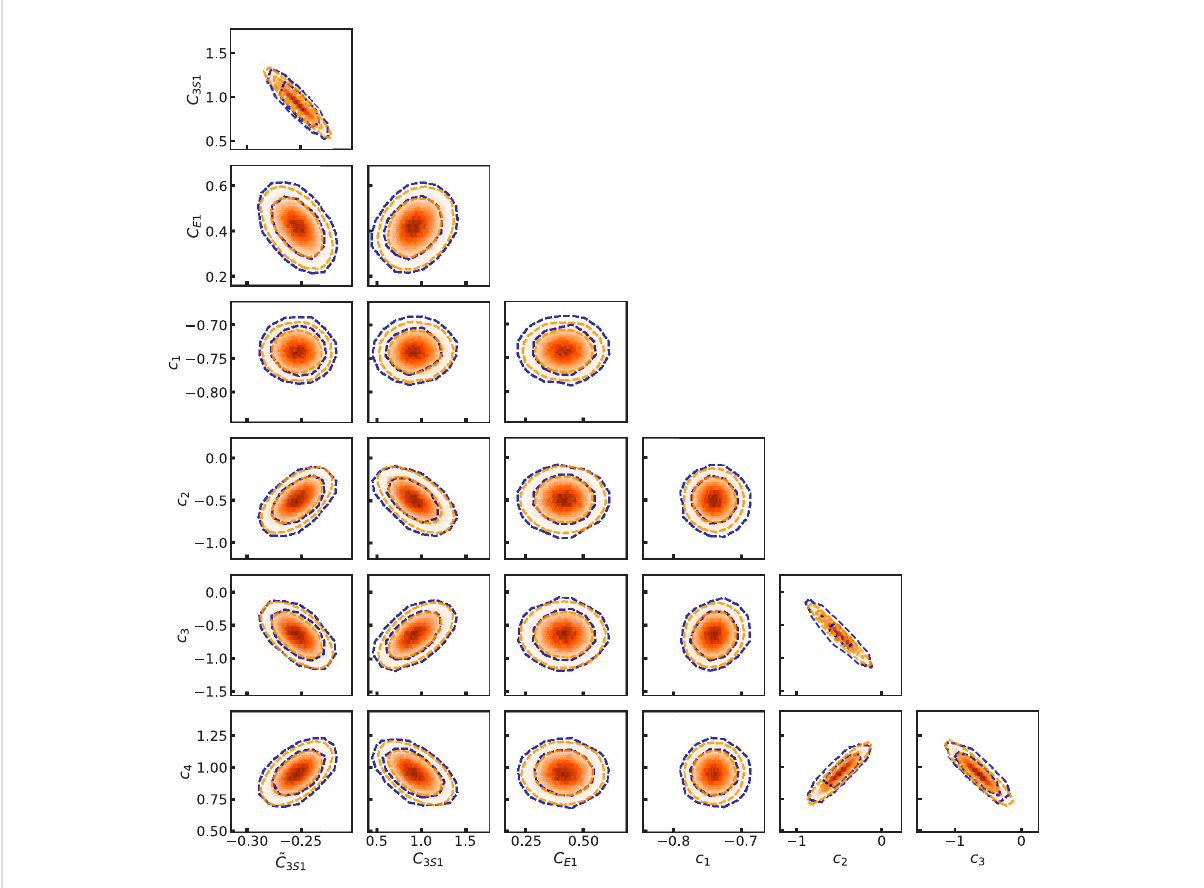
FIGURE 2 The joint posterior of LECs sampled with S/IR (blue) compared with MCMC sampling (orange). The LECs are shown in units of 10 4 GeV − 1 , 10 4 GeV − 2 and 10 4 GeV − 4 for c i , ~ C i and C i , respectively. The likelihood observables and assigned errors are given in Table 1. The contourlines indicate 68% and 90% credible